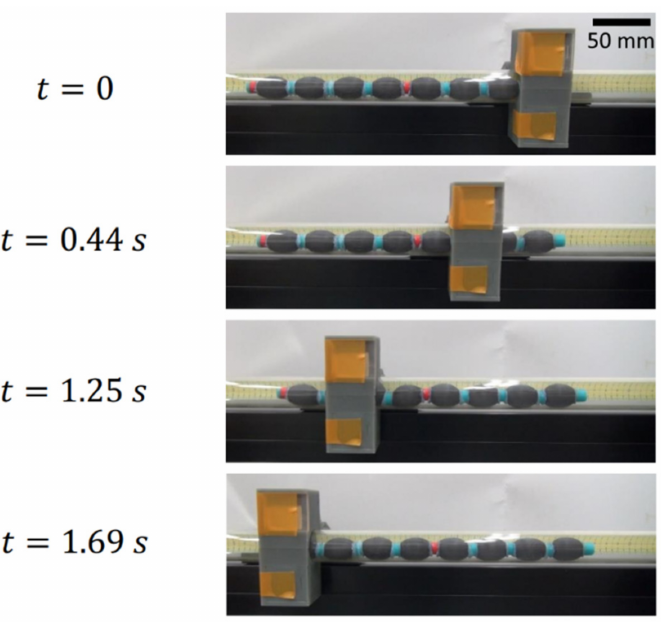
Figure 7. Peristaltic locomotion performed by the fabricated MAE